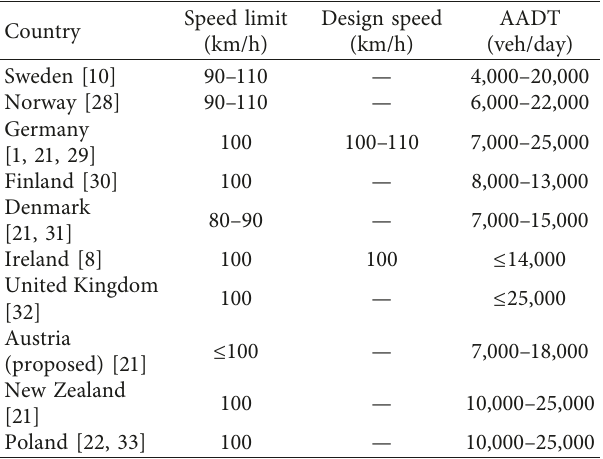
Table 1: Comparisonofinternational